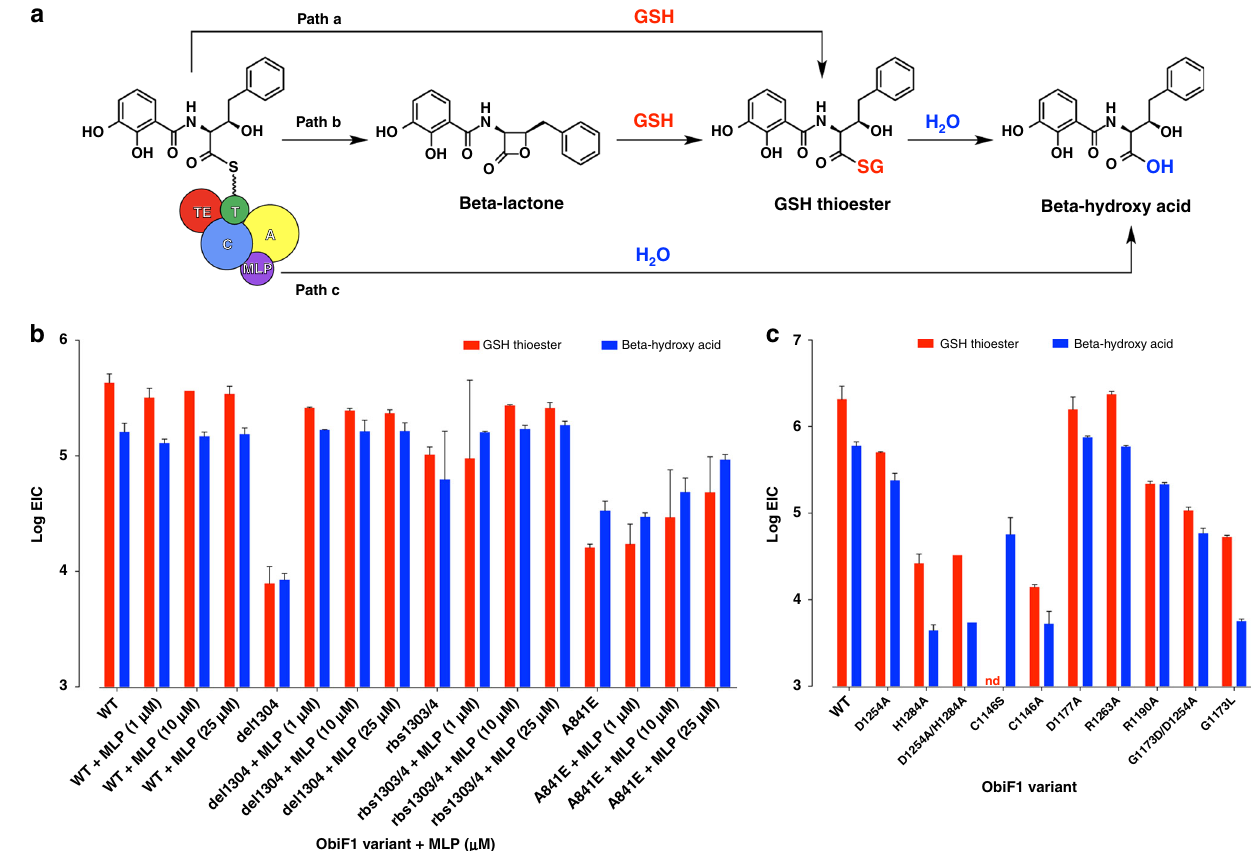
Fig. 4 Functional analysis of MLP-dependence and triad residues. a Three mechanistic pathways for product release from the penultimate N-(2,3-OH- benzoyl)- β -OH-homoPhe PCP thioester generated using an ObiF1/F2/H/D functional assay. GSH was included as a trapping agent to enable quanti fi cation of product ion counts by LCMS. Bar graphs in ( b ) and ( c ) represent extracted ion counts (EICs) for the GSH-thioester ( m / z = 621 for [M + H] + ion) and β - hydroxy acid ( m / z = 332 for [M + H] + ion) normalized to a phenylalanine internal standard at the 3-h reaction time point. The y -axis represents the log (EICs) and the x -axis denotes the ObiF1 variant used in the enzymatic reaction along with concentration of exogenous MLP (if added). Error bars represent standard deviations for at least two independent trials. Bar graphs for additional time points (0.5 and 24 h) are provided in the Supplementary Information. nd = not detected by